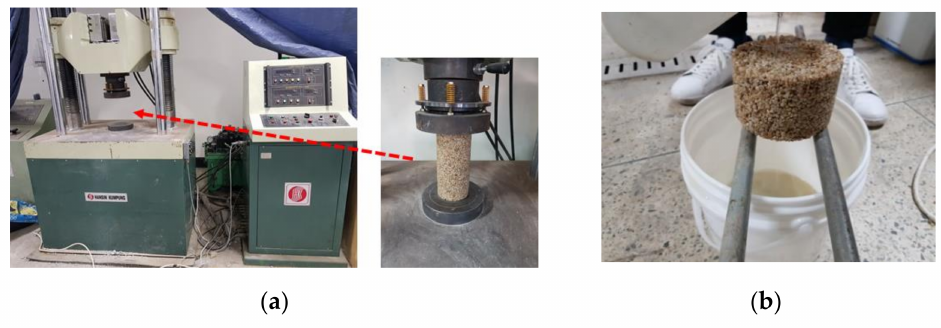
Figure 3. Experimental setup of ( a ) the compressive strength and ( b ) the water permeability